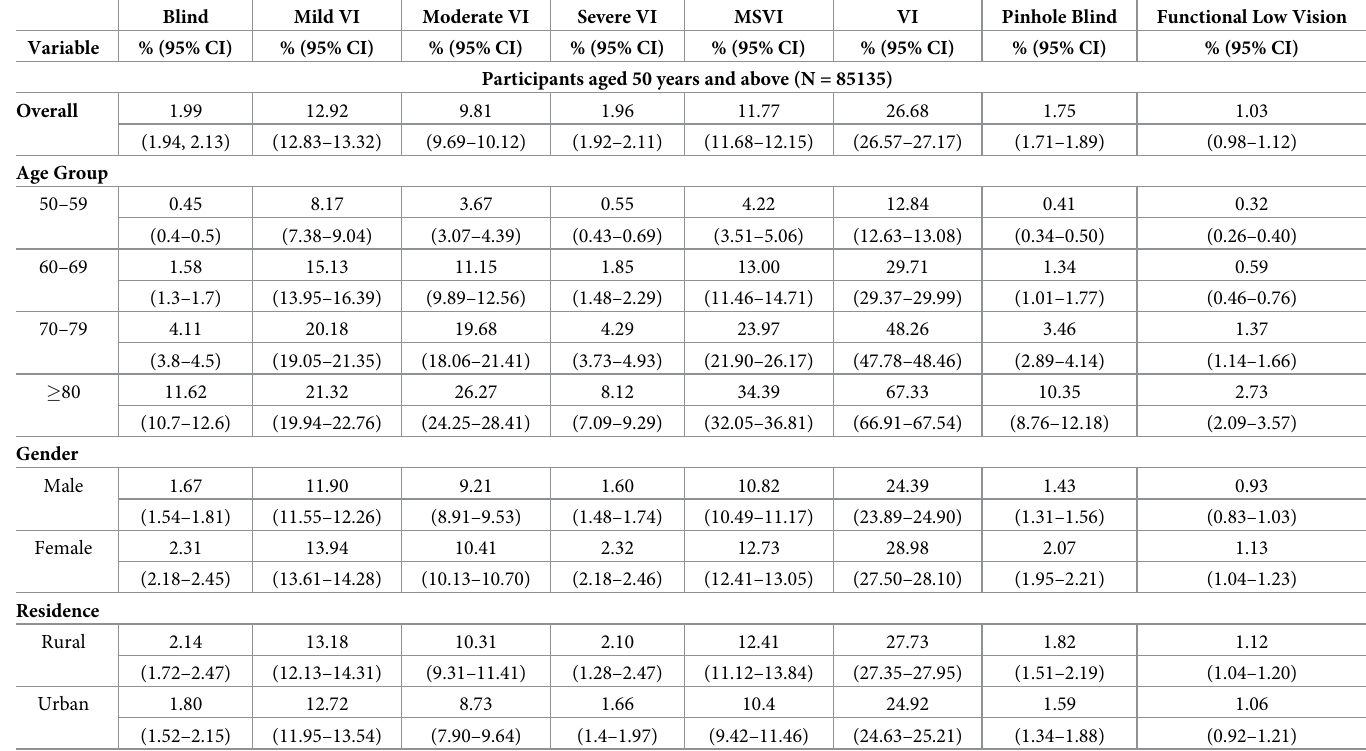
Table 3. Prevalence of blindness and visual impairment in population aged � 50